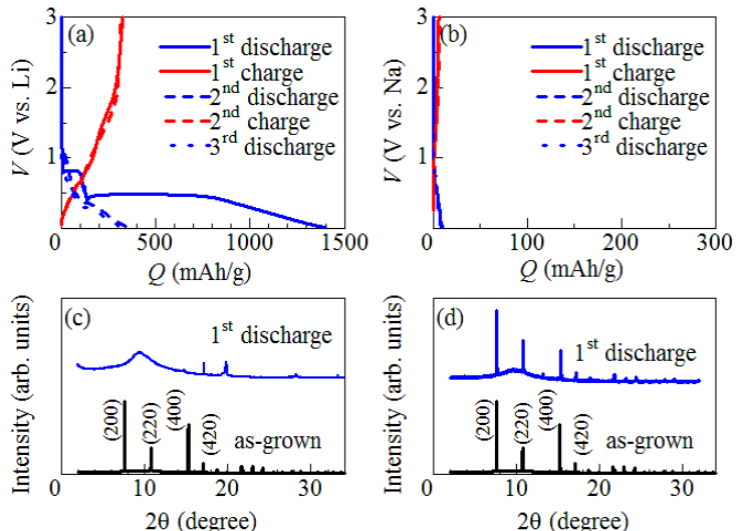
Figure 2. Charge/discharge curves of the Mn-PBA films against ( a ) Li and ( b ) Na; ( c ) X-ray diffraction (XRD) patterns of as-grown and discharged films in lithium-ion secondary battery (LIB); and ( d ) XRD patterns of the as-grown and discharged films in sodium-ion secondary battery (SIB). The wavelength of the incident X-ray was 0.69923 Å. The parentheses represents the index with face-centered cubic ( Fm 3 m : Z = 4)